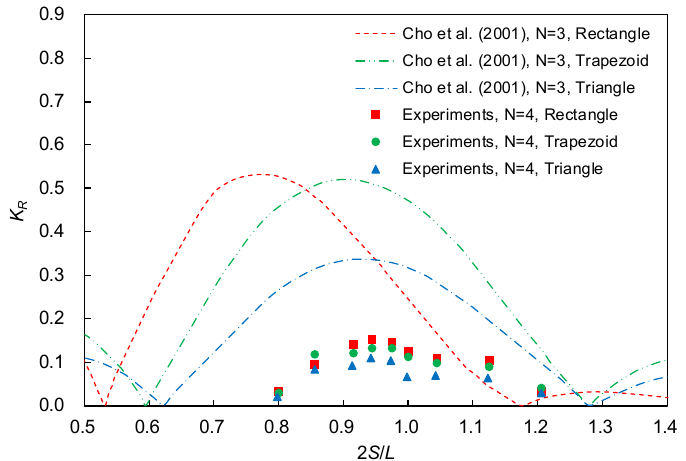
Figure 16. Comparison of the Bragg resonant reflection coefficient K R with section shapes of bars (Cho et al. [5]).